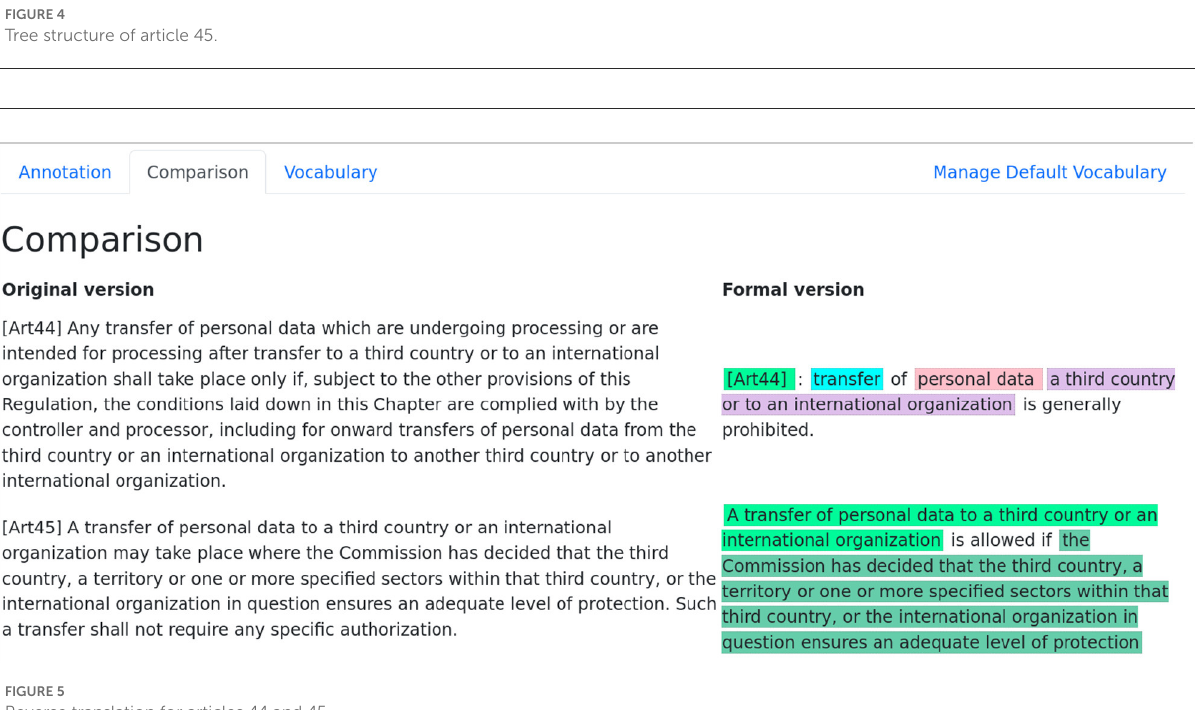
FIGURE4 Tree structure of article 45.